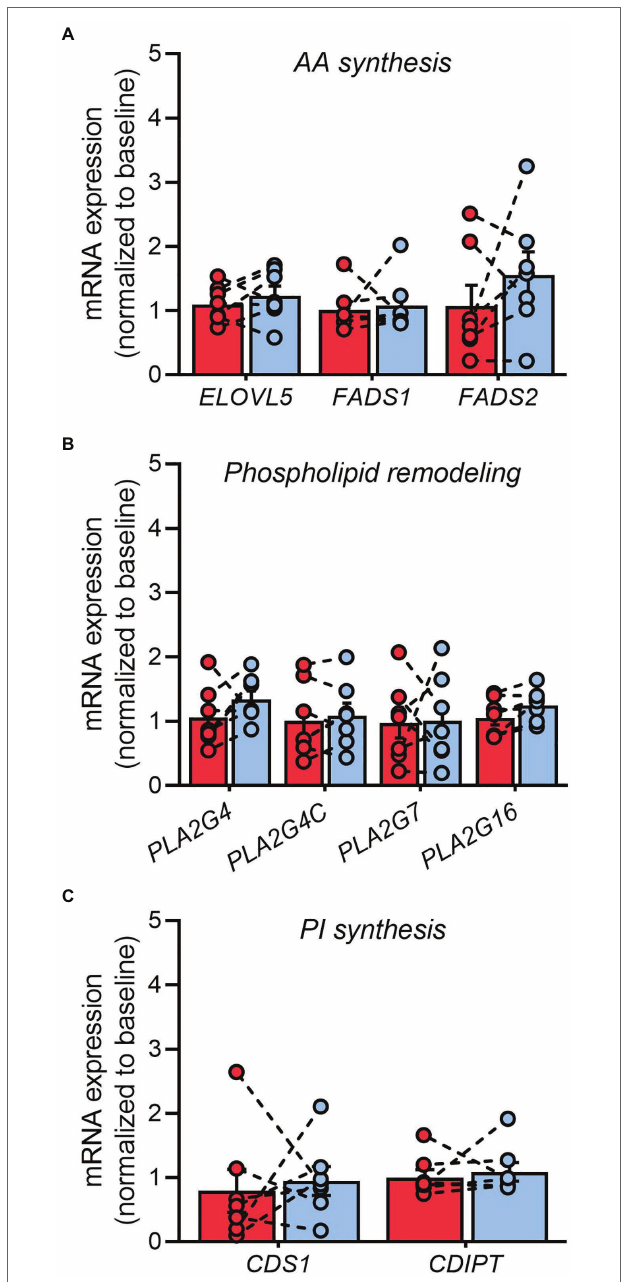
FIGURE 7 | Pioglitazone does not influence phospholipase gene expression in adipose tissue. Fold change in the adipose tissue mRNA expression of genes involved in arachidonic acid synthesis (A) , glycerophospholipid hydrolysis (B) , and phosphatidylinositol synthesis (C) following 6 months of 45 mg/day pioglitazone treatment. Target genes were first normalized to the geometric mean of ACTB and GAPDH and subsequently normalized to the average of Baseline samples. ELOVL5 (fatty acid elongase 5), FADS1 (fatty acid desaturase 1), FADS2 (fatty acid desaturase 2), PLA2G4 (cytosolic phospholipase A2), PLA2G4C (cytosolic lysophospholipase), PLA2G7 (lipoprotein-associated phospholipase A2), PLA2G16 (adipose-specific phospholipase A2), CDS1 (CDP-diacylglycerol synthase 1), CDIPT (CDP-diacylglycerol-inositol-3- phosphatidyltransferase/phosphatidylinositol synthase). Data are mean ± standard error (filled bars) and individual values (filled circles) for n = 7